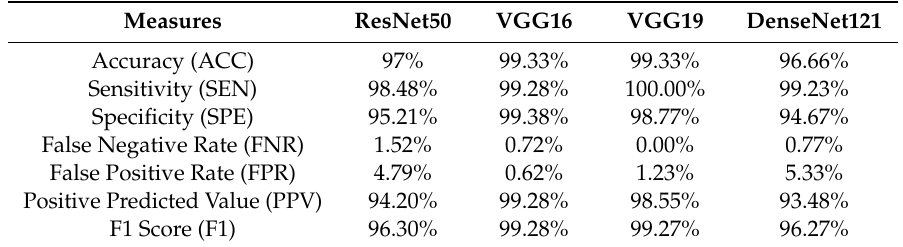
Table 2. Comparative performance of ResNet50, VGG16, VGG19, and DenseNet121 for COVID-19 diagnosis using X-ray